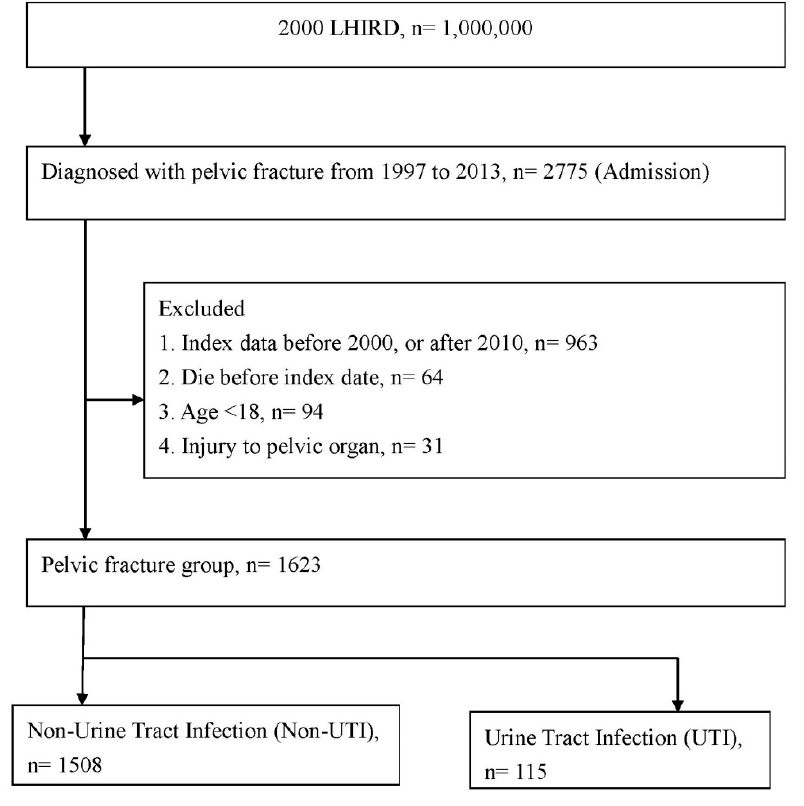
Table 1. Baseline characteristics among study groups.